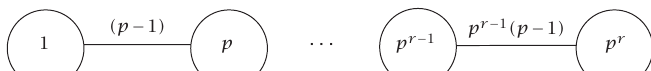
(cid:2) (cid:3) p r .